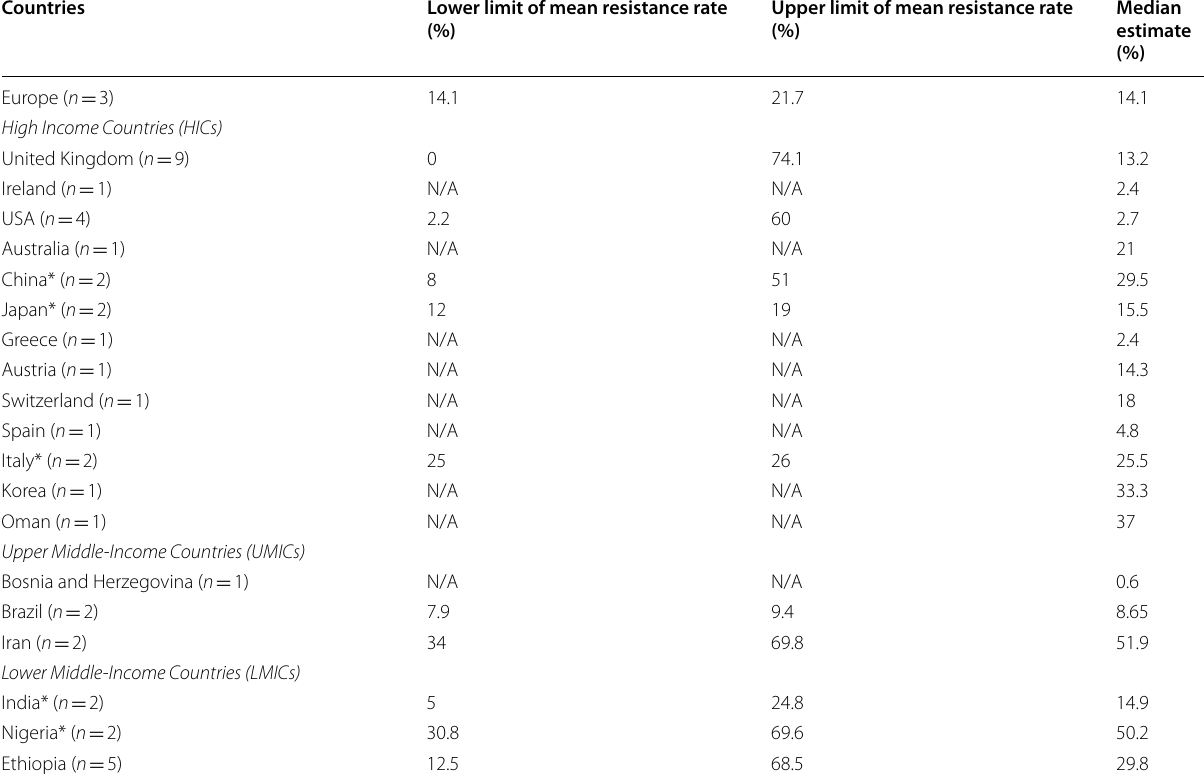
Table 4 Median estimates for resistance rates according to country/region (2000–2022)